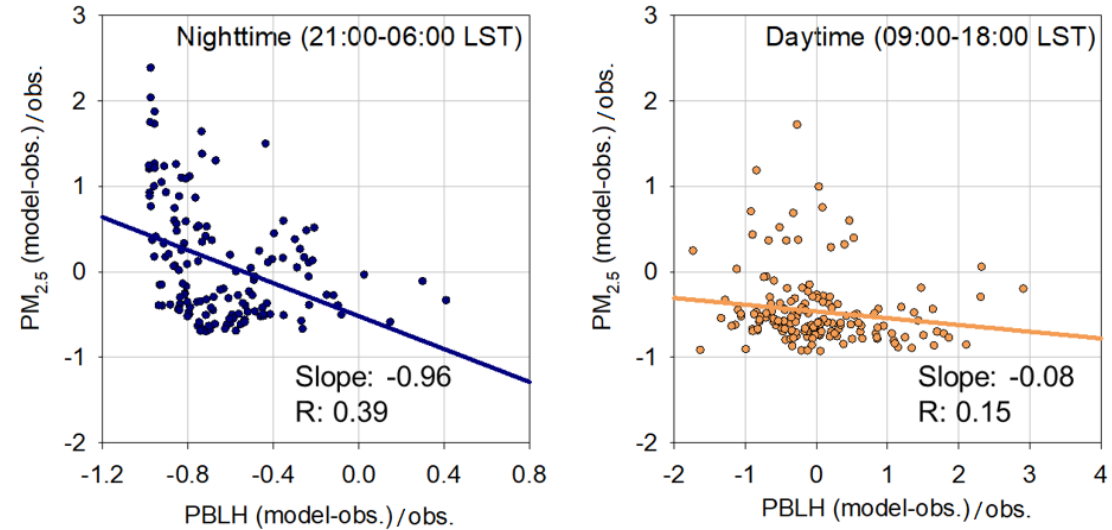
Figure 7. Scatter diagrams of normalized means differences [NMD = (S − O)/O] between PBLH versus PM 2.5 interactions for ( a ) daytime (09:00–18:00 LST) (left) and ( b ) nighttime (21:00–6:00 LST) (right) simulations. Here S and O indicate simulations and observations, respectively.